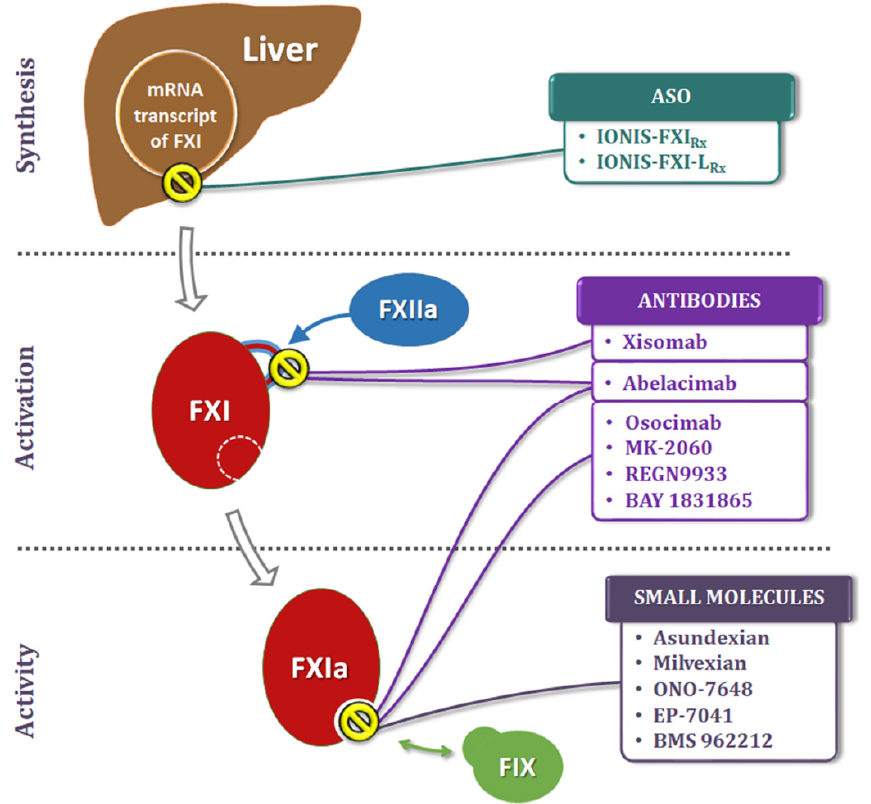
Figure 3. Sites of action (represented by the yellow circles) of the factor XI/XIa inhibitory drugs currently at different stages of clinical development. The anti-FXI ASOs (Antisense Oligonucleotides) block mRNA transcription of FXI in the hepatocytes, thus inhibiting its synthesis. Some monoclonal antibodies attach to the catalytic domain of FXI and block its FXIIa-mediated conversion to the active FXIa form, thus locking it in the inactive zymogen state. Most of the currently in development anti-FXIa antibodies act similar to the small molecule FXIa inhibitors and bind to the active site(s) on FXIa, thereby blocking its activity.